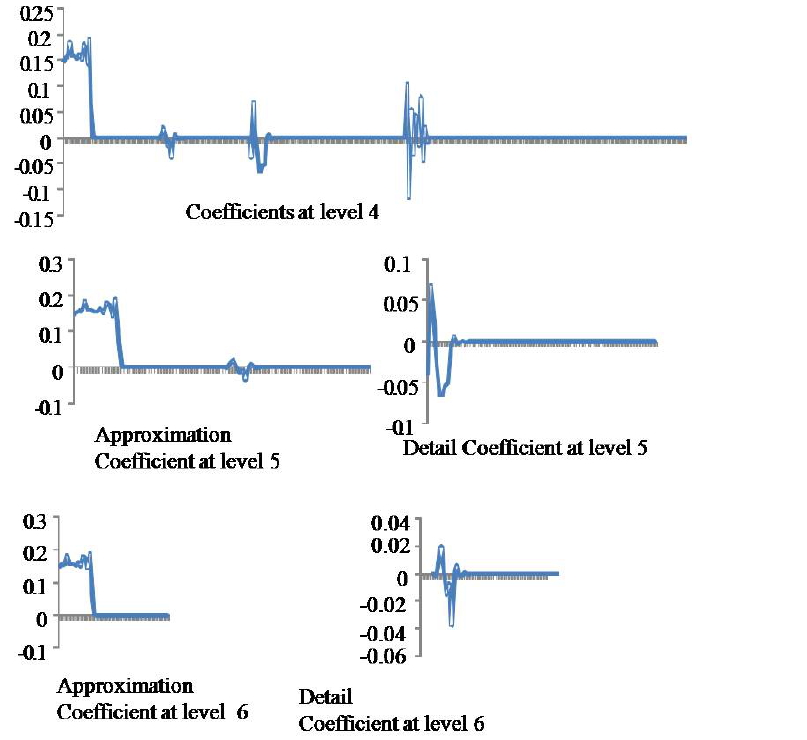
Figure 2. Three levels in the Wavelet Decomposition of IR-ATR signals.